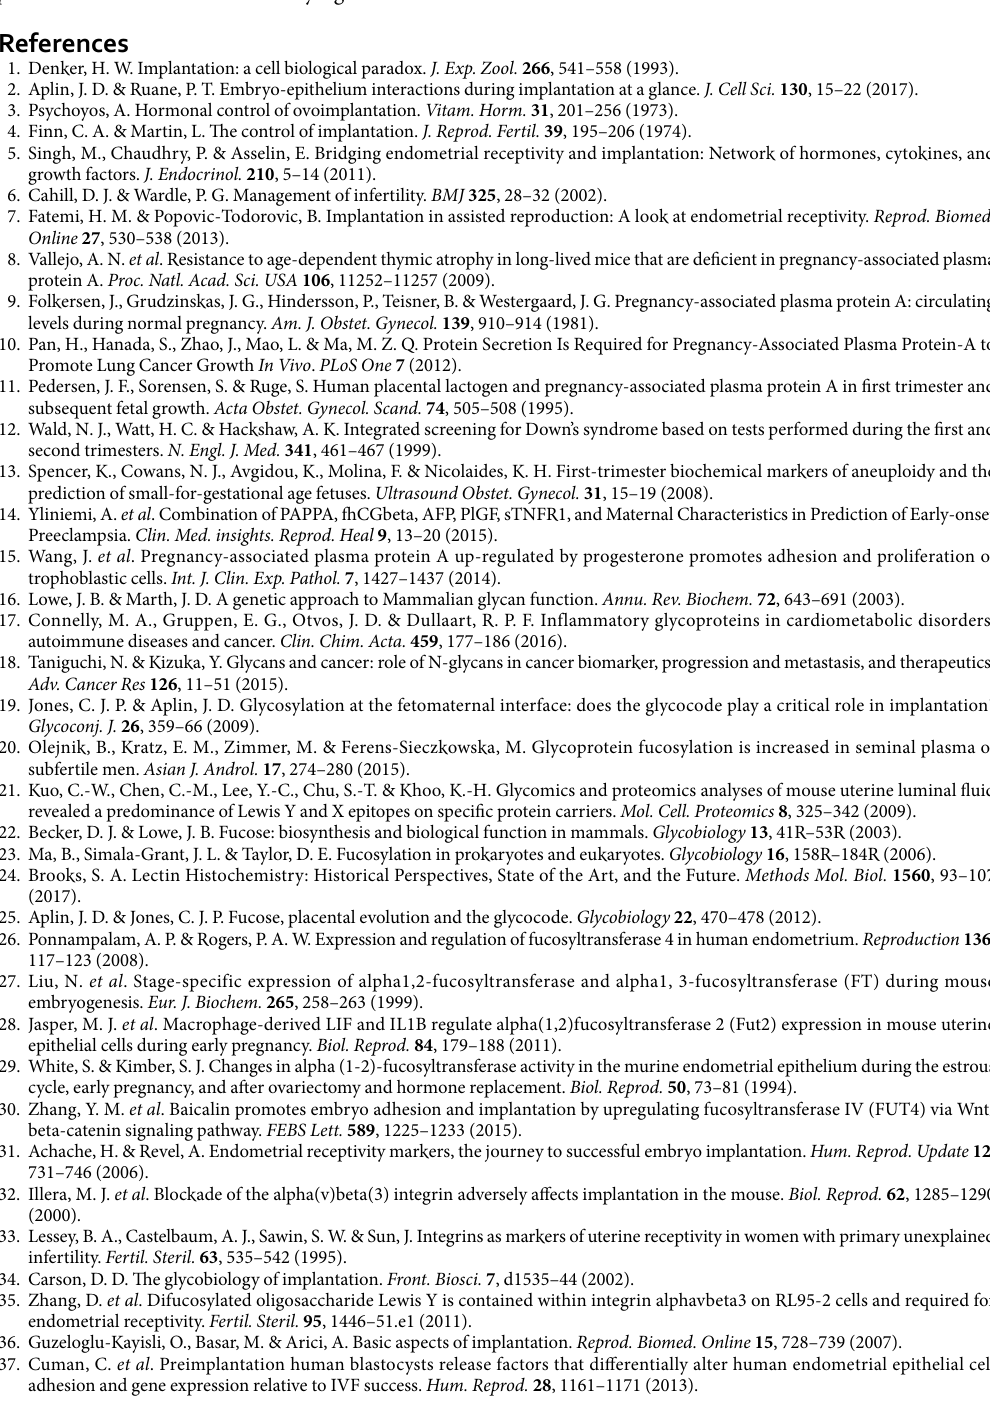
co-culture medium with primary endometrial